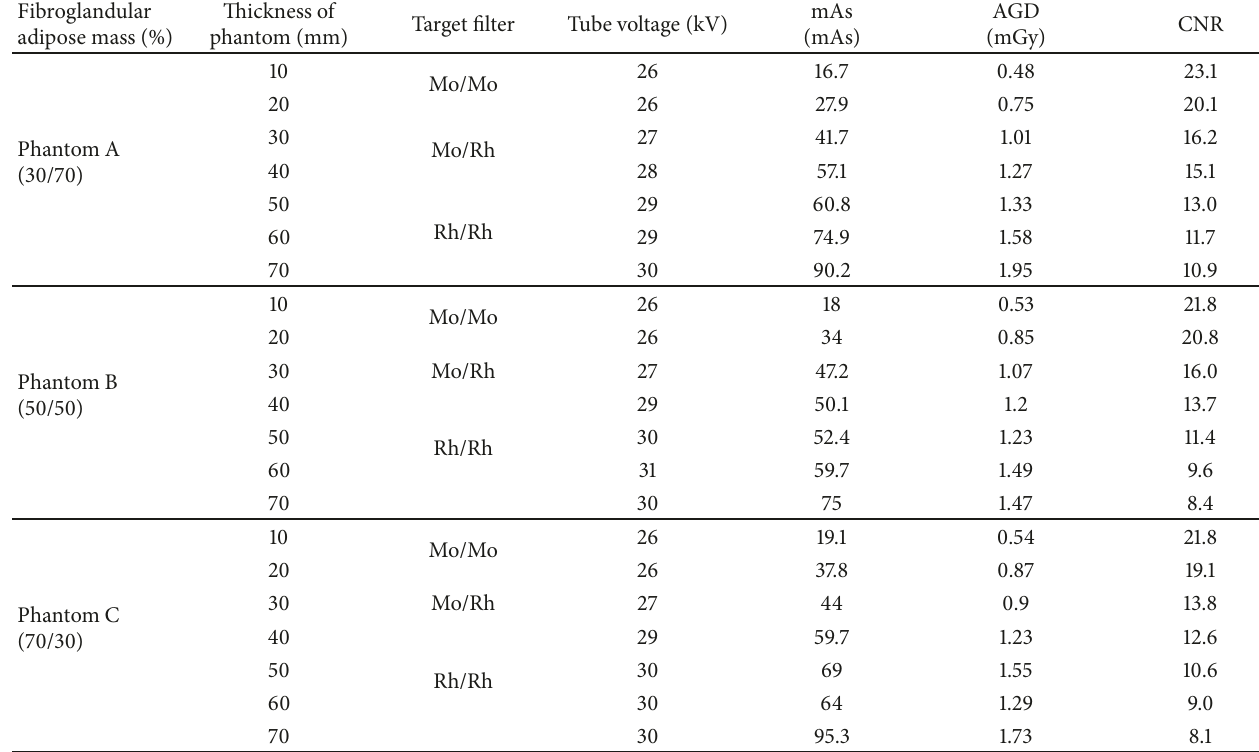
Table 1: CNR values based on mammary gland density and imaging conditions.